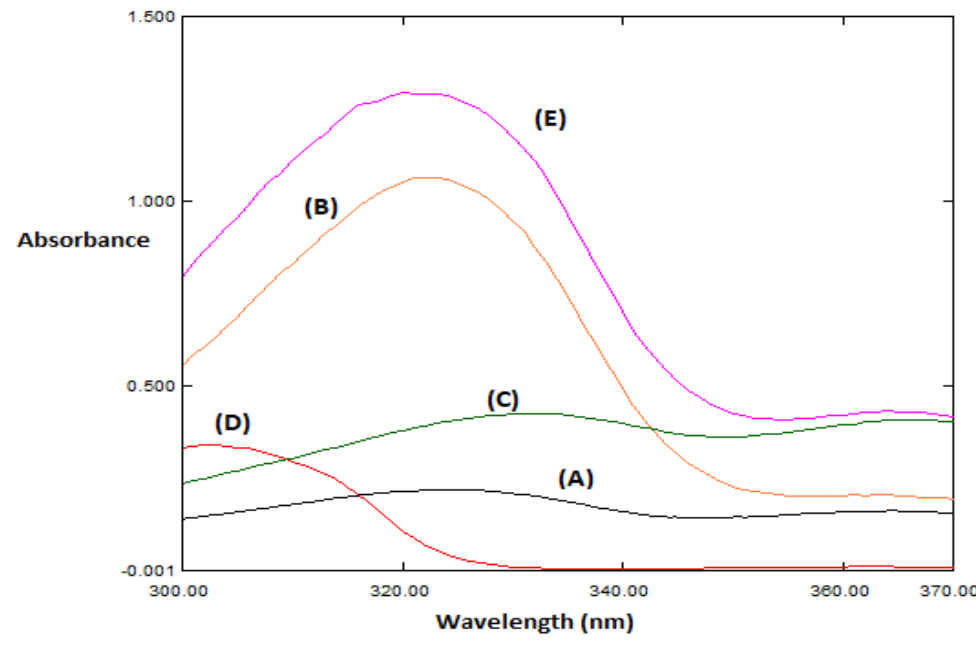
Figure 2. The absorption spectra of (A,B) 3 and 20 µ g mL − 1 FVR, respectively, (C) 3 µ g mL − 1 Impurity-1, (D) 3 µ g mL − 1 impurity-2; and (E) mixture of 20 µ g mL − 1 FVR, 3 µ g mL − 1 Impurity-1, and 3 µ g mL − 1 Impurity-2 in methanol.